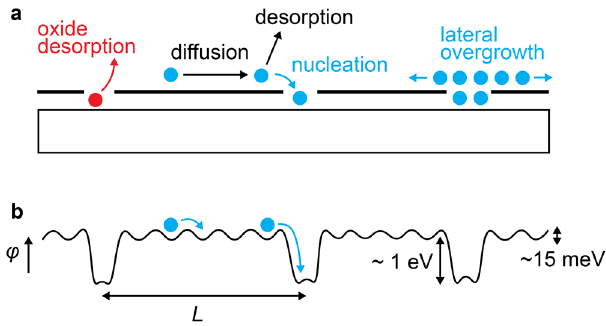
Fig. 6 Fast surface diffusion favors seeded lateral epitaxy at pinholes. a Pinholes are created by the native oxide desorption, which then serve as nucleation sites for epitaxial growth. b Schematic potential ϕ for adatoms diffusing on the graphene-terminated surface, with diffusion length λ . Seeded lateral epitaxy is expected when L << λ , where L is the spacing between pinholes. Remote epitaxy requires L > λ